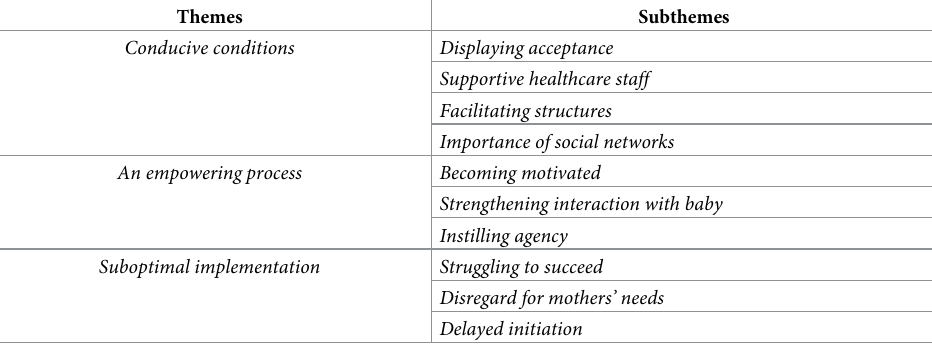
Table 1. Themes and subthemes representing caregivers’ experiences of